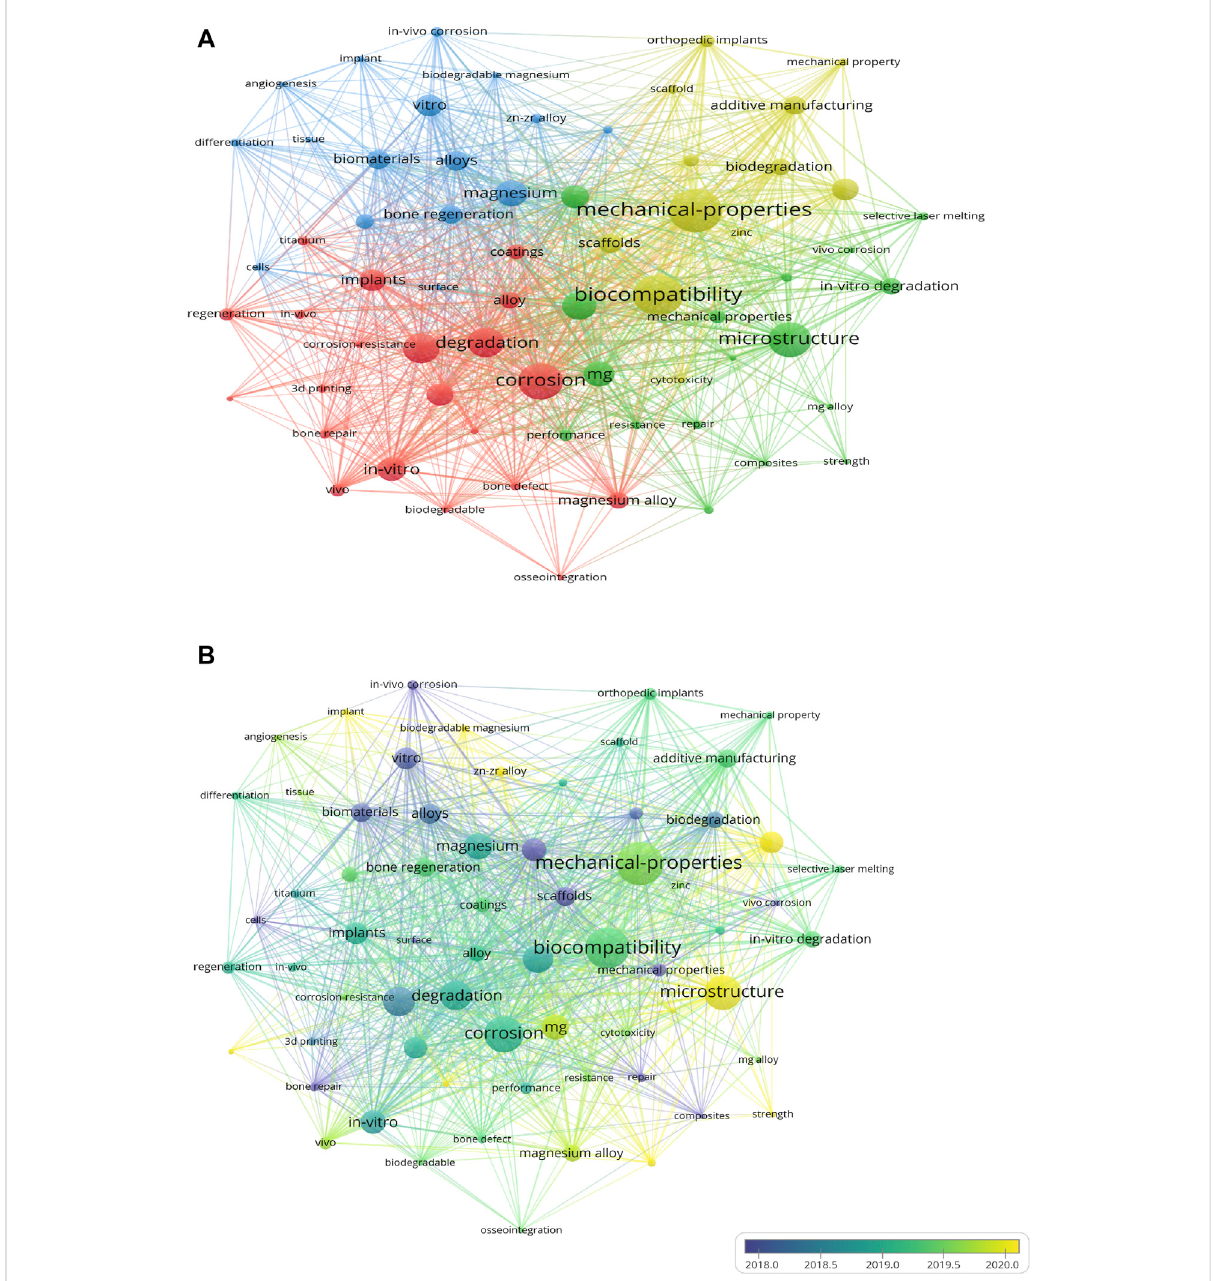
FIGURE 2 Co-occurrenceanalysisoftheglobalresearchonMgalloysandbonedefectsintheWebofScience (A) Co-occurrenceanalysisofkeywordson Mg alloys and bone repair (B) The distribution of keyword contributions is based on the average frequency of occurrence. Blue and green keywords emerge earlier than yellow